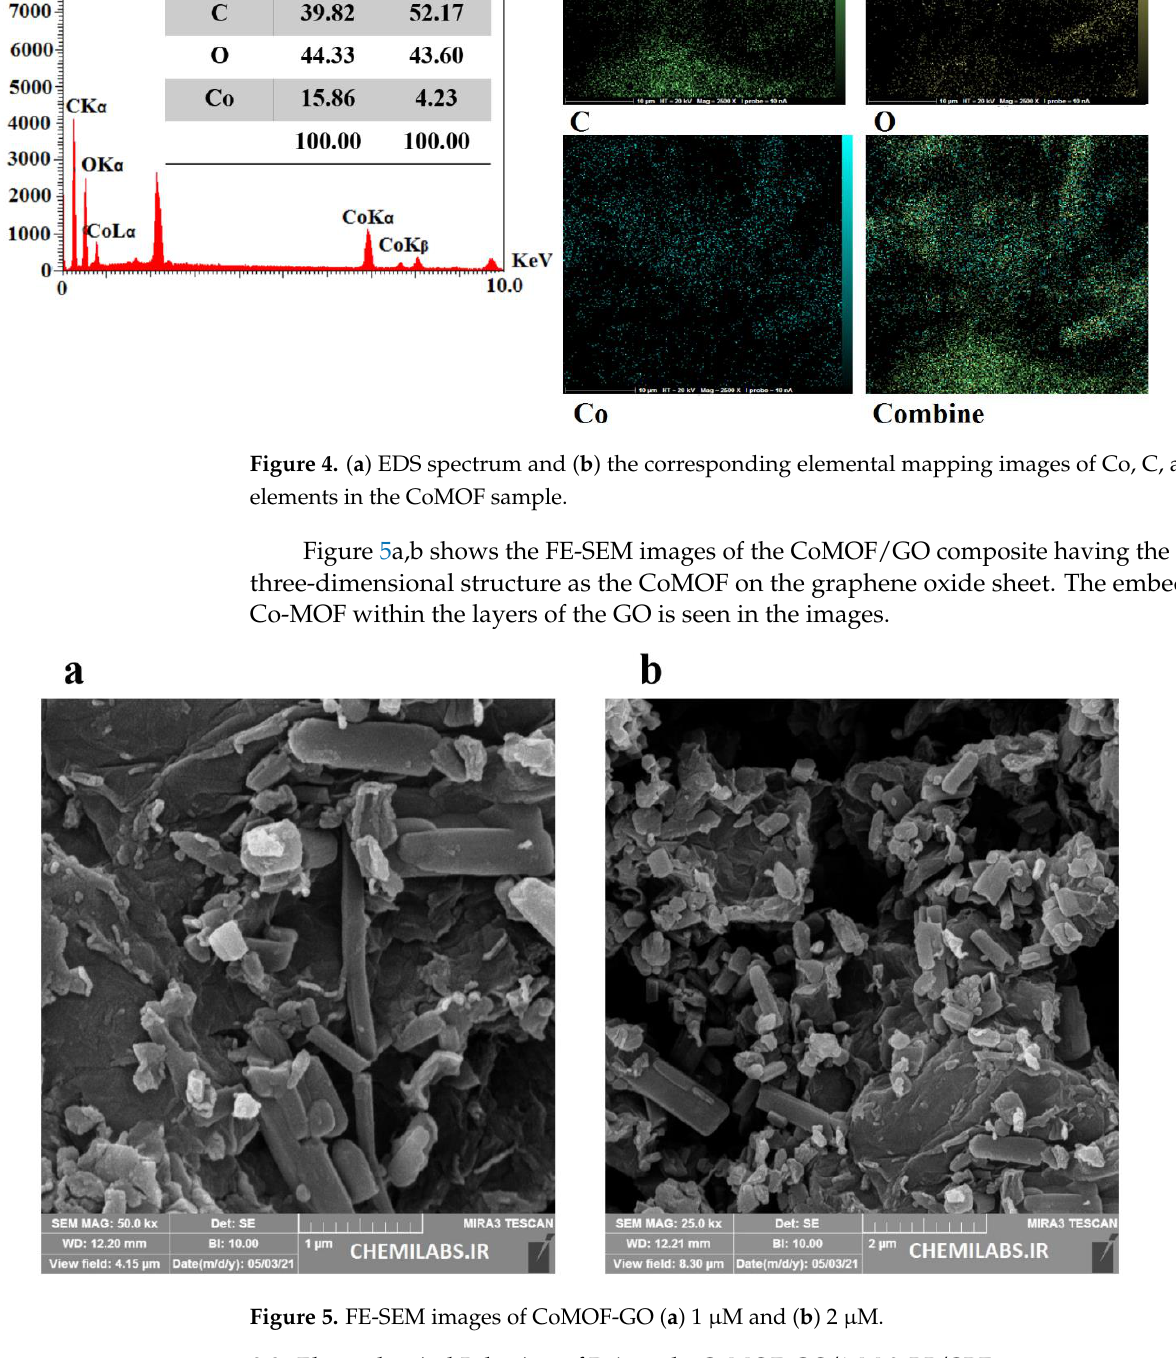
Figure 5. FE-SEM images of CoMOF-GO ( a ) 1 µM and ( b ) 2